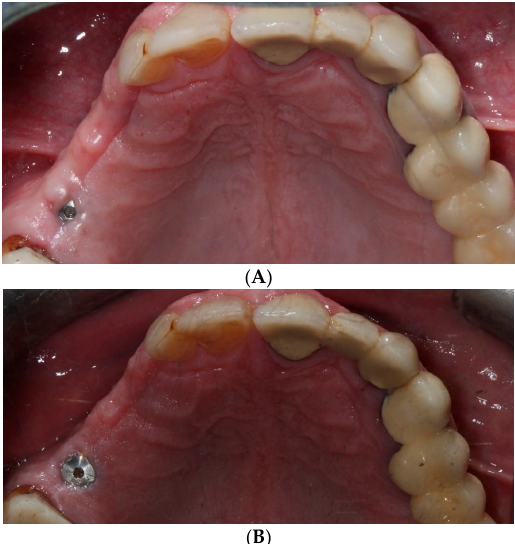
Figure 3. ( A ) EC implant, cover screw one month after placement; ( B ) EC implant, cover screw 3 months after placement.